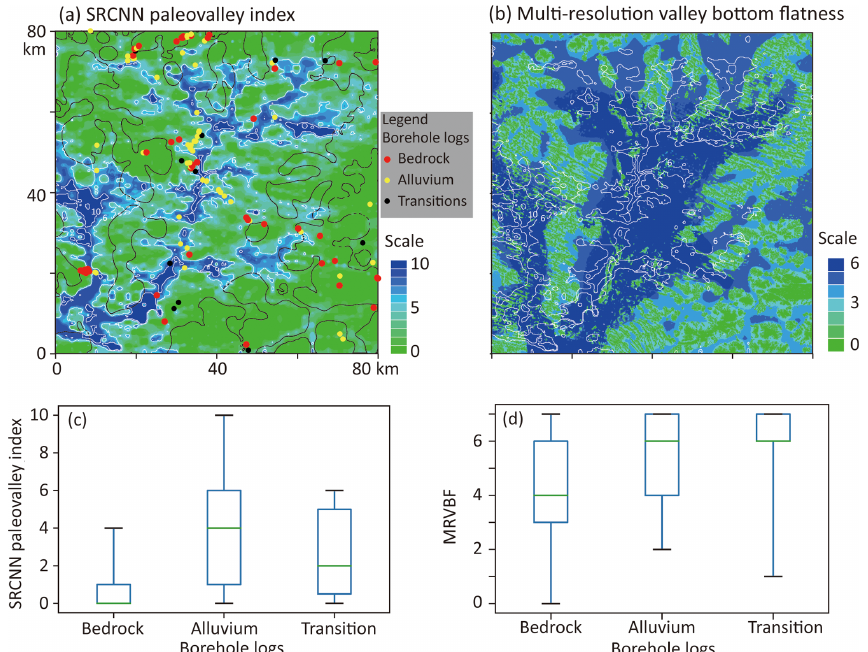
Figure 10. (a) SRCNN paleovalley index by aggregating the binary paleovalley in the vertical direction within 100m; (b) multiple resolution valley bottom flatness (MRVBF) indicating the position of alluvium sediment accumulation. The black lines show the boundary between paleovalley and non-paleovalley interpreted from (b) , while the white lines represent the contour lines of SRCNN paleovalley index from (a) . The boxplot of SRCNN paleovalley index (c) and MRVBF (d) with respect to the borehole logs showing bedrock, alluvium and transition between bedrock and